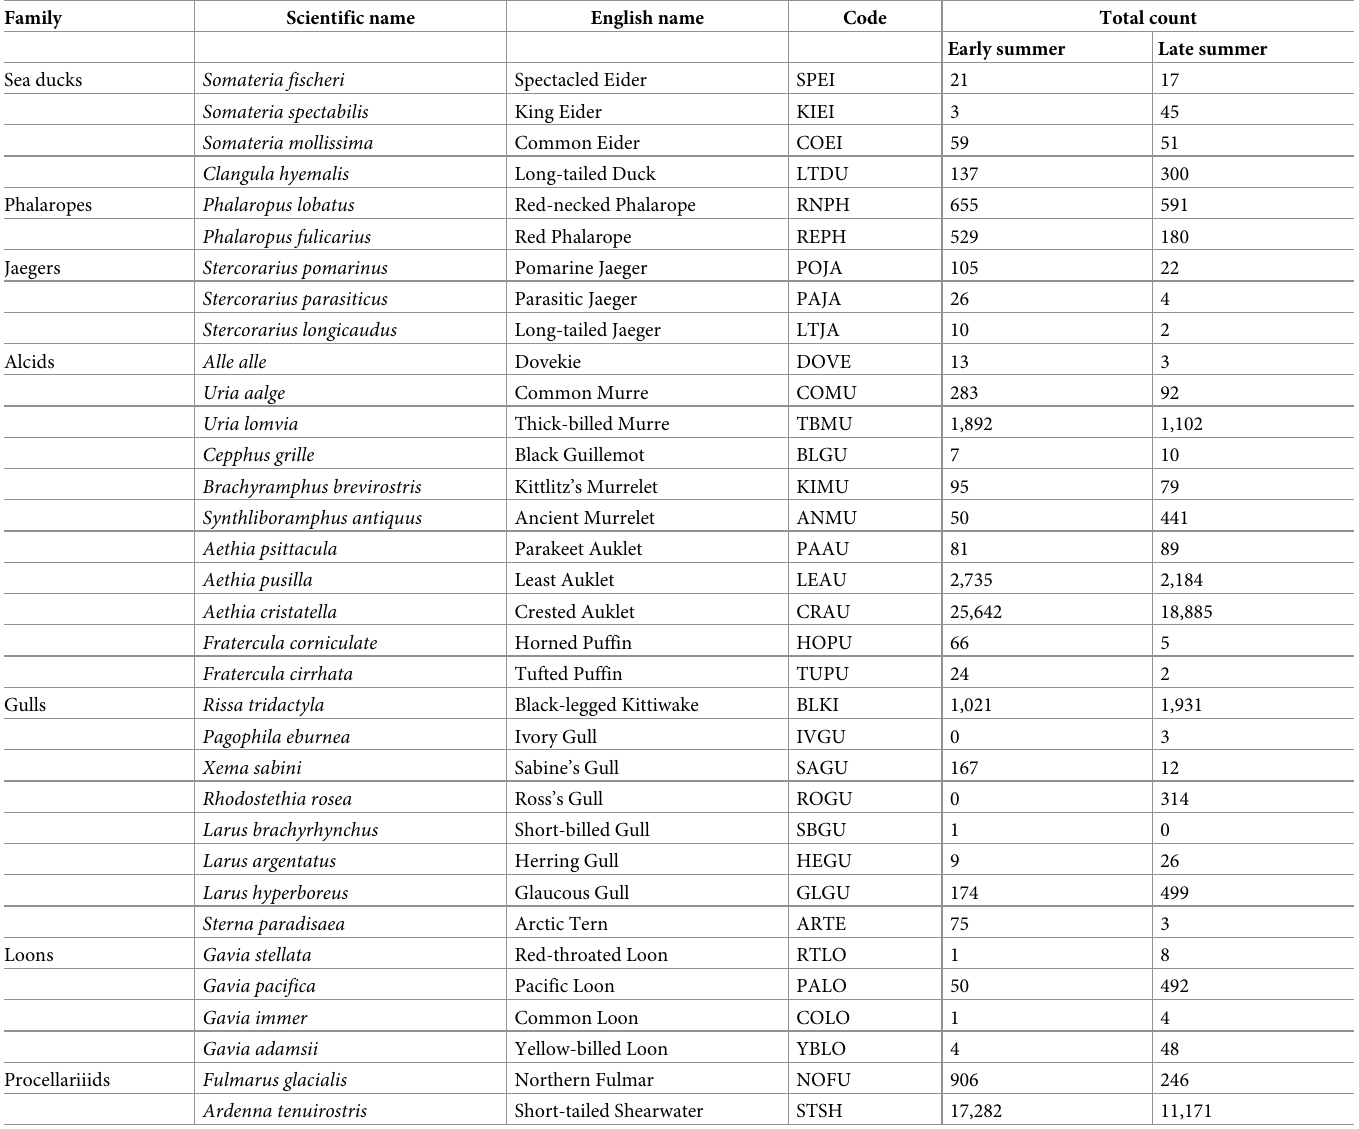
Table 2. Species of seabirds recorded during ship-based surveys in the northeastern Chukchi Sea,